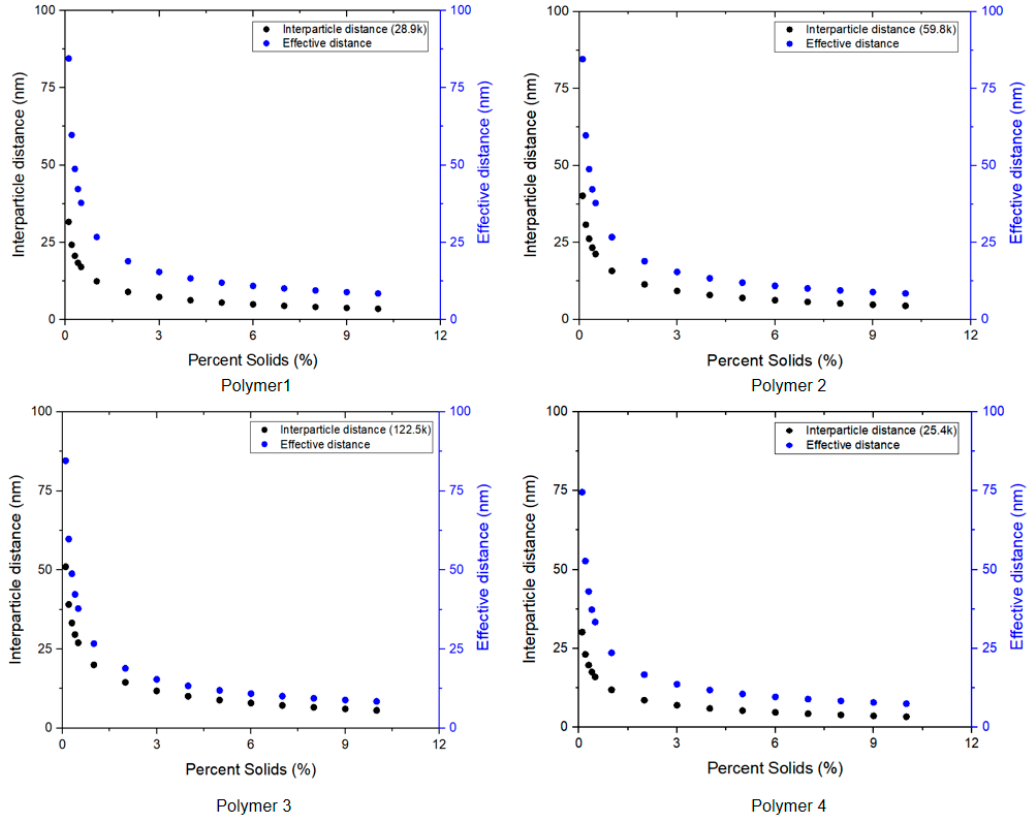
Figure 7. Comparison of effective distance and inter-particle distance for Polymer 1–4.